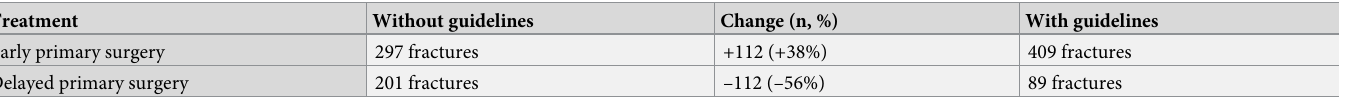
Table 5. Presentation of how treatment could change with the new guidelines and implemented fast-track based on a retrospective cohort study of 1,635 distal radius fractures (DRF) in two hospitals in Sweden in 2014–2017.